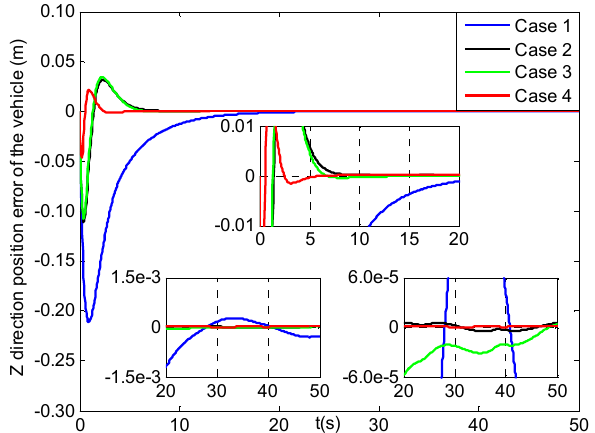
Figure 24. Z direction position errors of the vehicle (four cases).